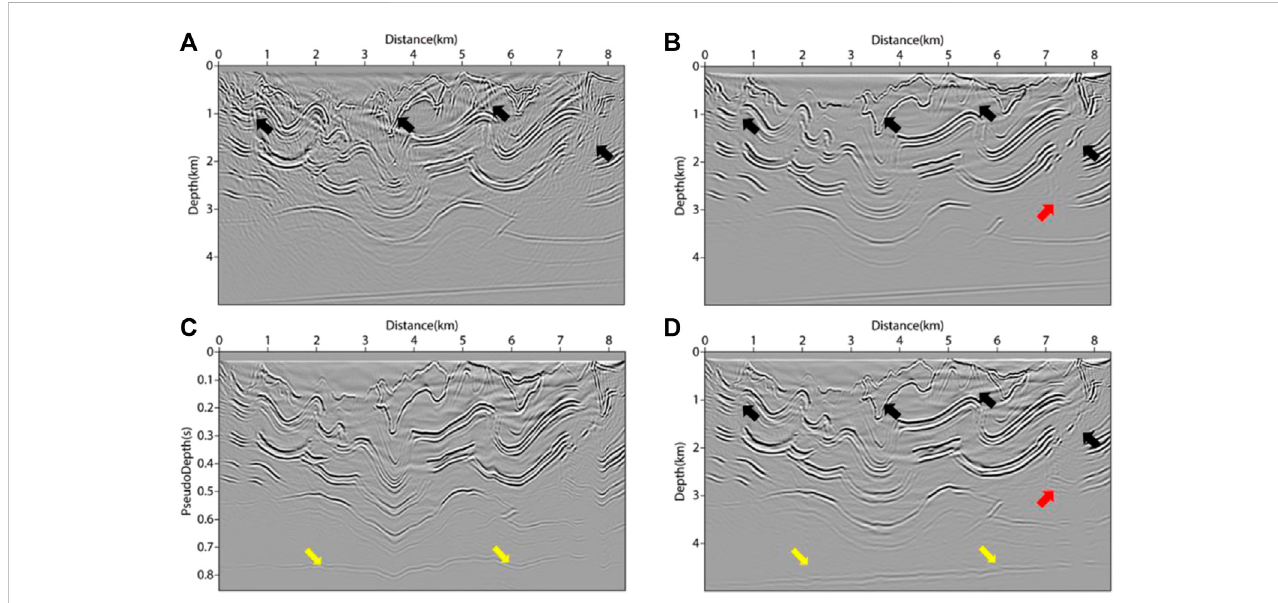
FIGURE 14 Migration results of complex overthrust model under GPU acceleration strategy. (A) acoustic isotropy RTM method; (B) VTI-RTM method in depth domain; (C) VTI-PDRTM method in pseudo-depth domain; (D) VTI-PDRTM method transformed back to the depth